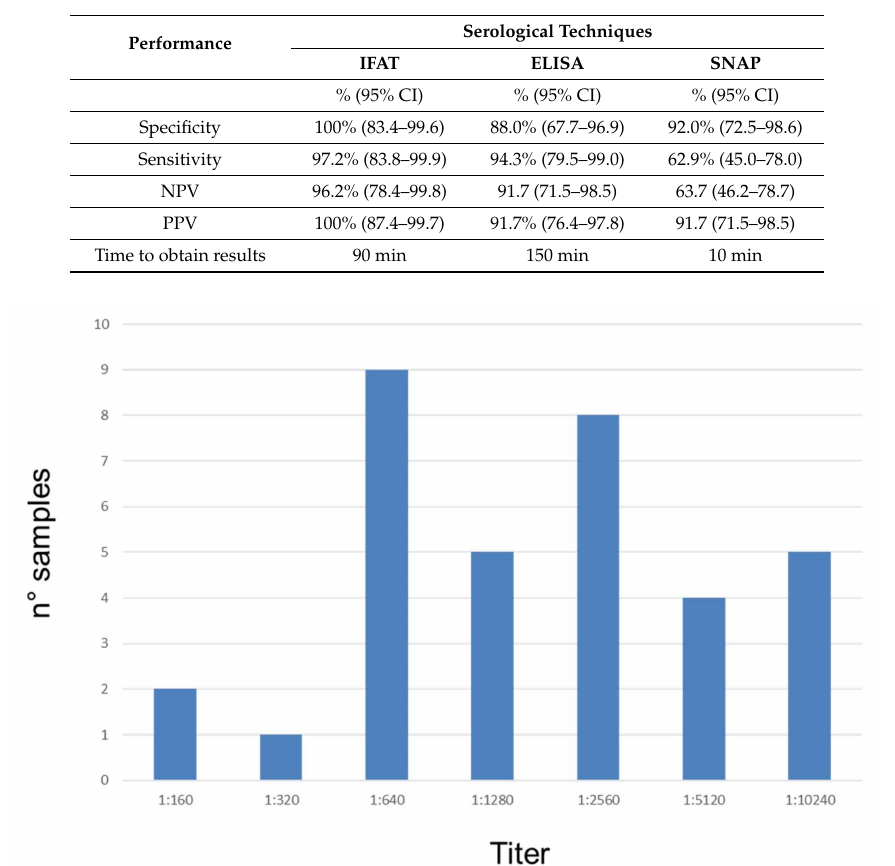
Table 5. Performances of serological techniques tested.